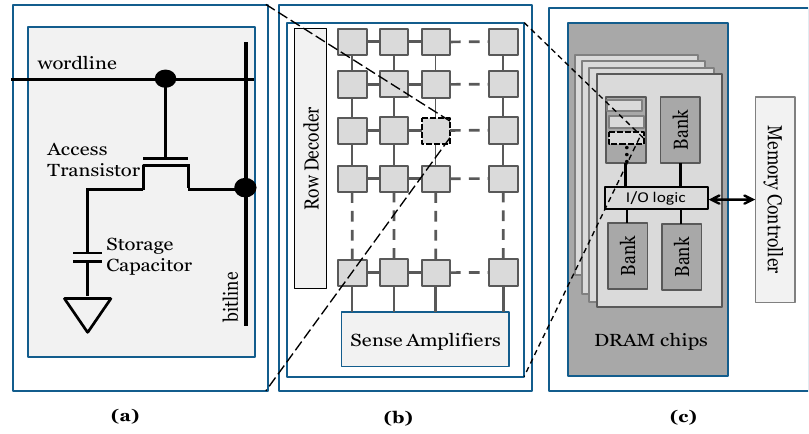
Figure 1. DRAM organization [12]. ( a ) DRAM cell. ( b ) DRAM subarray. ( c ) DRAM device.